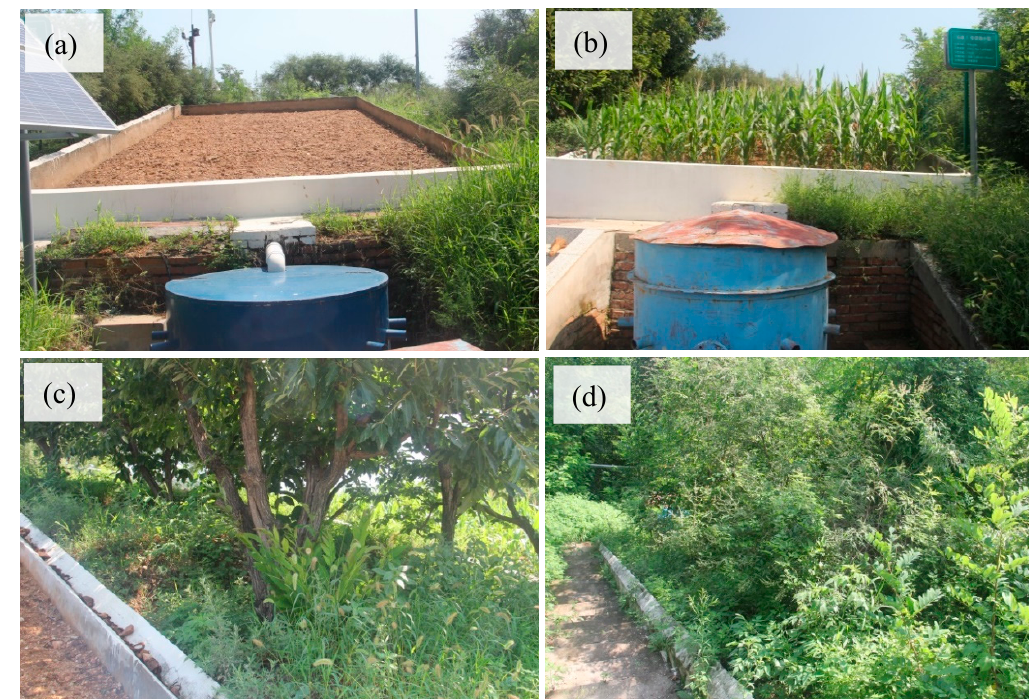
Figure 4. Photos taken at the experimental station: ( a ) bare plot, ( b ) cultivated plot, ( c ) Chestnut plot, and ( d ) forest plot.